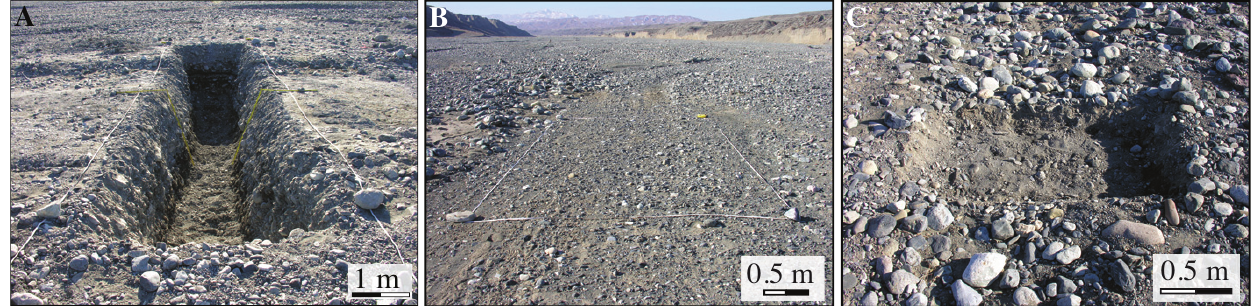
Fig. 3. (a) View of the deep trench dug to sample the Urumqi river bed. This trench is 7m long, 1.2m large and 0.8m deep after removing the surface layer ( ∼ 20cm). (b) and (c) Examples of a grid and a shallow trench used to sample single morpho-sedimentary elements. The grid presented here is 4m long and 3m large, whereas the trench is 1.5m long, 1m large and 0.2m deep.